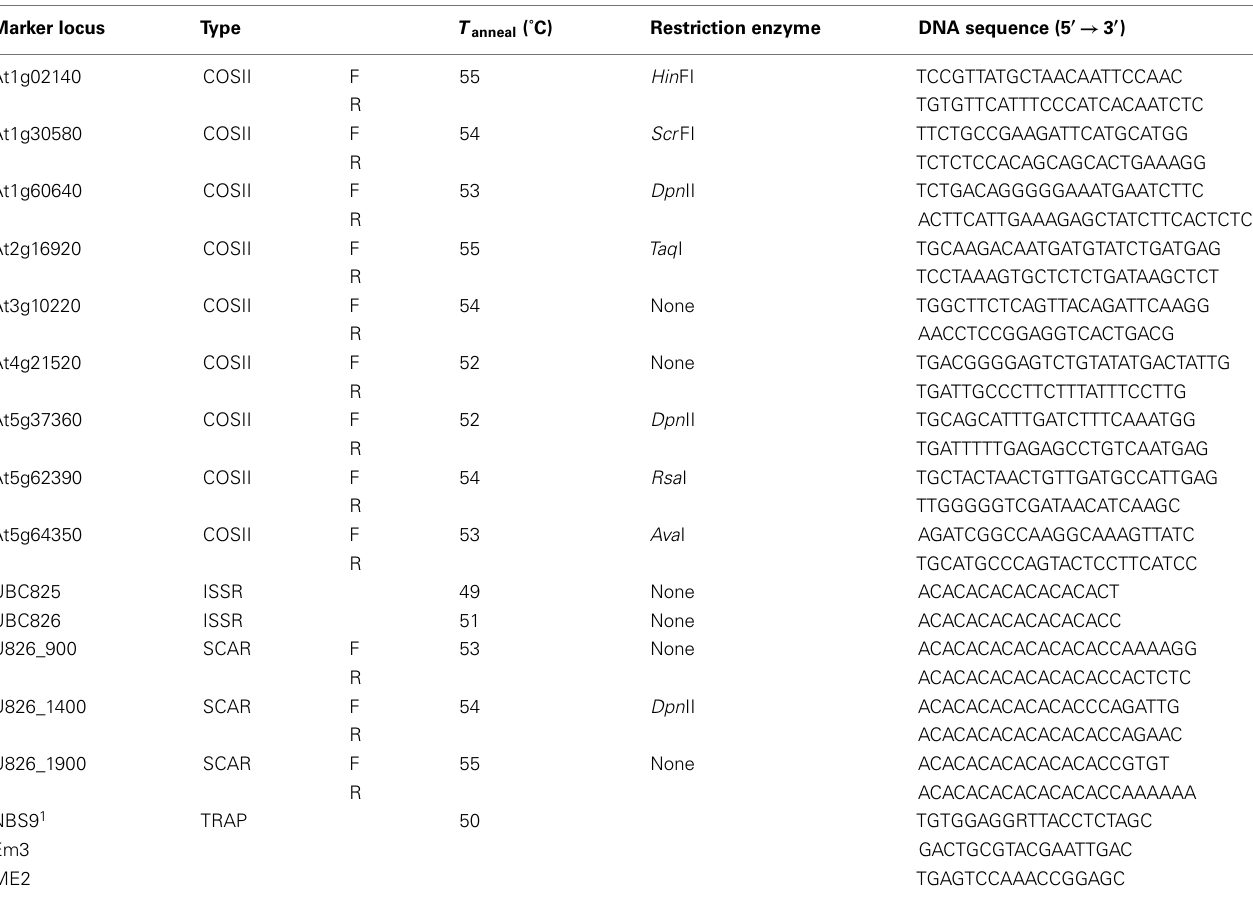
Table 4 | Primers used for PCR amplification of COSII, SCAR, ISSR, andTRAP markers in N. langsdorffii . Marker locus Type T anneal (˚C) Restriction enzyme DNA sequence (5 (cid:48) → 3 (cid:48)